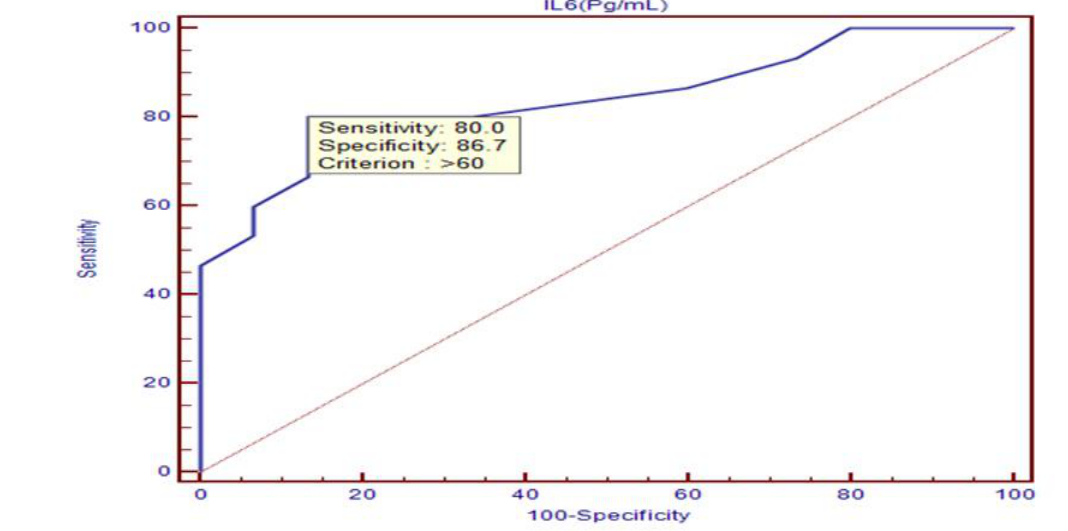
Figure 4. ROC curve analysis for IL-6 serum level (pg/mL) to predict severity of COVID-19 among the